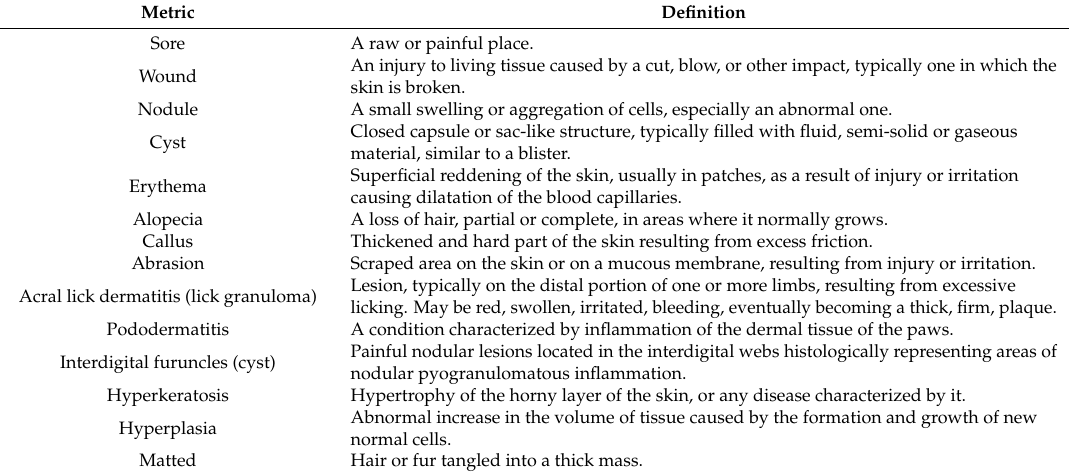
Table 3. Elbow, hock, and paw conditions. Name and description of conditions assessed. Metric Definition Sore A raw or painful place. An injury to living tissue caused by a cut, blow, or other impact, typically one in which the Wound skin is broken. Nodule A small swelling or aggregation of cells, especially an abnormal one. Closed capsule or sac-like structure, typically filled with fluid, semi-solid or gaseous Cyst material, similar to a blister. Superficial reddening of the skin, usually in patches, as a result of injury or irritation Erythema causing dilatation of the blood capillaries. Alopecia A loss of hair, partial or complete, in areas where it normally grows. Callus Thickened and hard part of the skin resulting from excess friction. Abrasion Scraped area on the skin or on a mucous membrane, resulting from injury or irritation. Lesion, typically on the distal portion of one or more limbs, resulting from excessive Acral lick dermatitis (lick granuloma) licking. May be red, swollen, irritated, bleeding, eventually becoming a thick, firm, plaque. Pododermatitis A condition characterized by inflammation of the dermal tissue of the paws. Painful nodular lesions located in the interdigital webs histologically representing areas of Interdigital furuncles (cyst) nodular pyogranulomatous inflammation. Hyperkeratosis Hypertrophy of the horny layer of the skin, or any disease characterized by it. Abnormal increase in the volume of tissue caused by the formation and growth of new Hyperplasia normal cells. Matted Hair or fur tangled into a thick